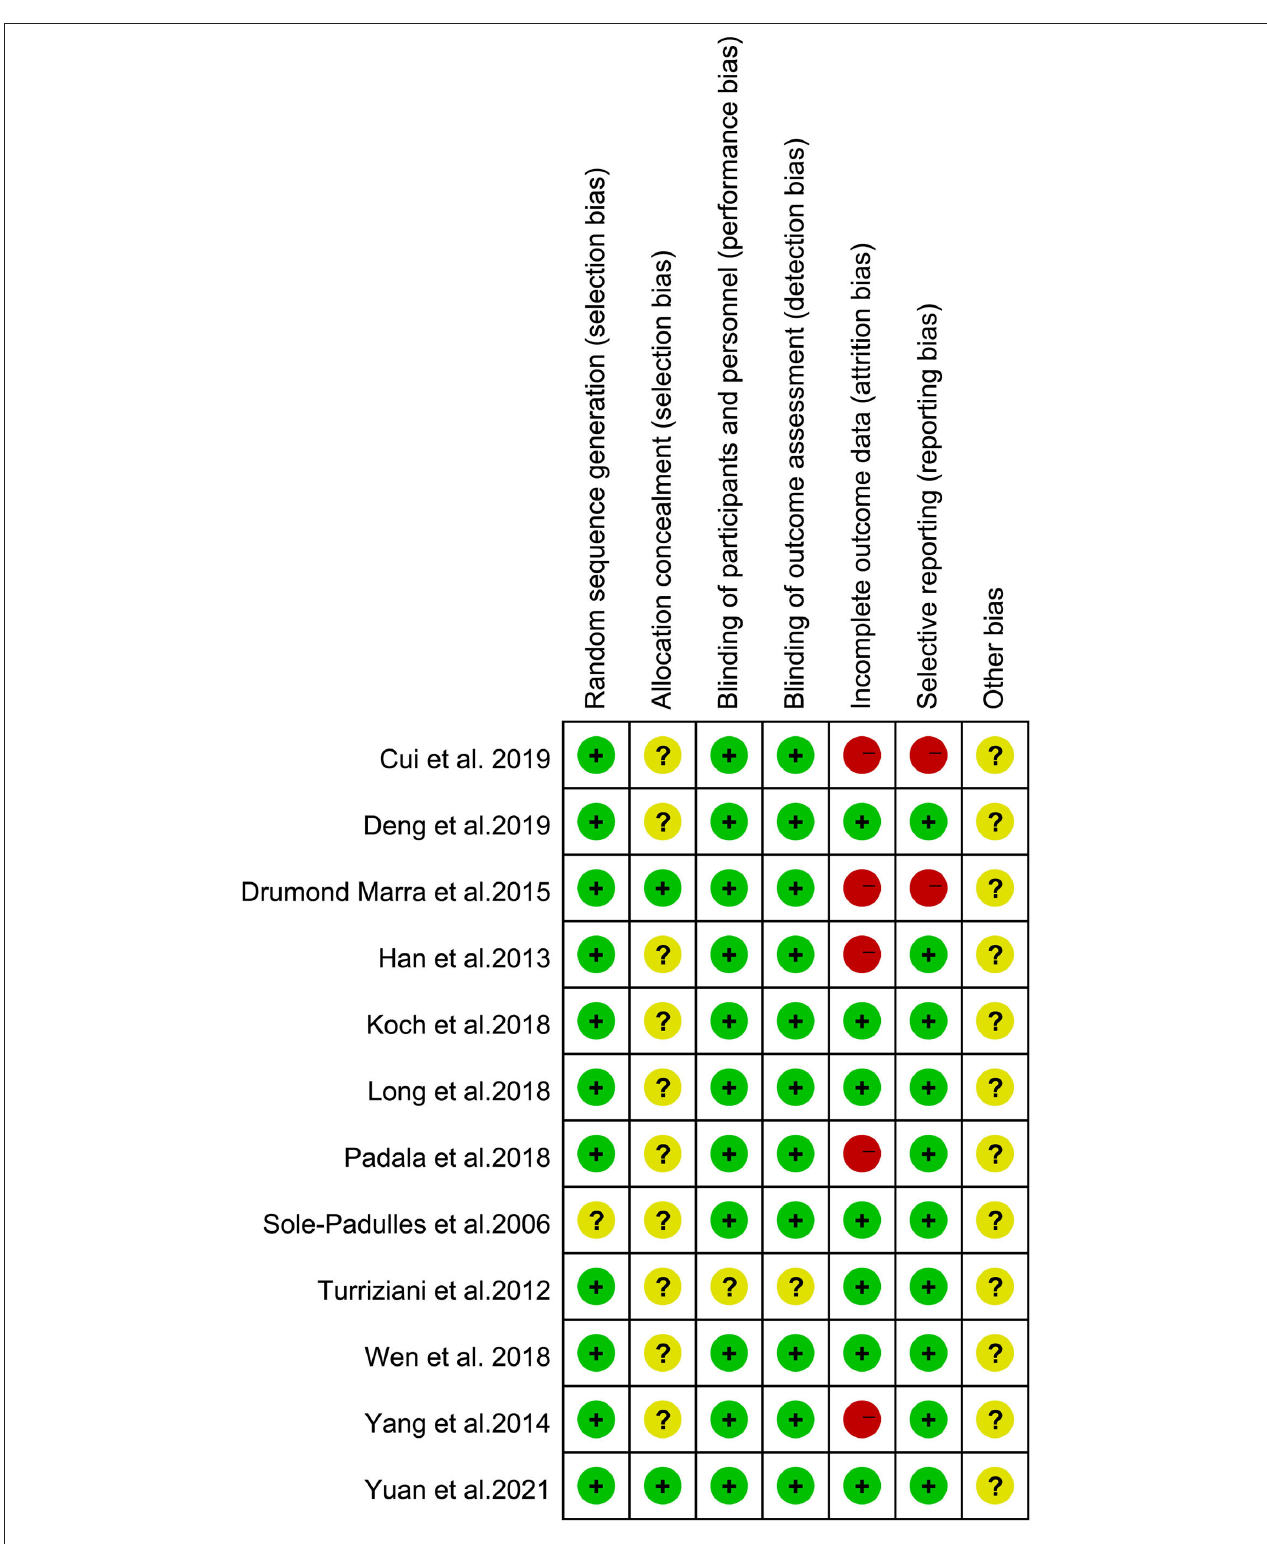
FIGURE 2 | Risk of bias summary: review authors’ judgments about each risk of bias item for each included study.